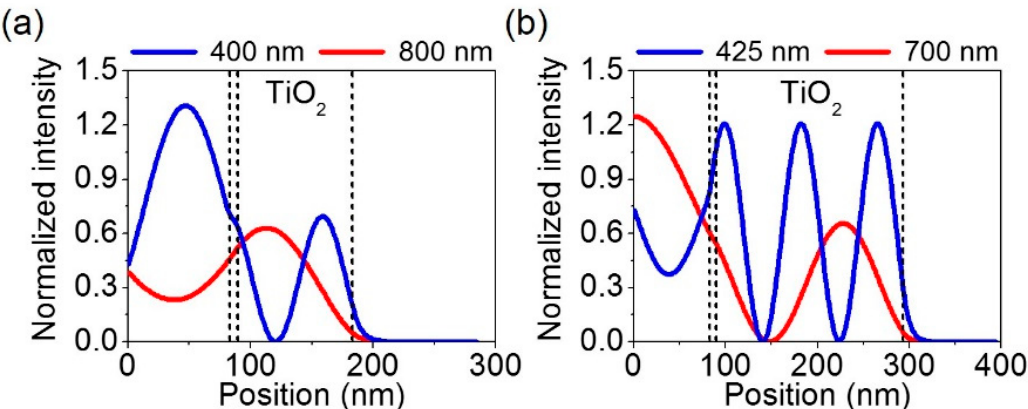
Figure 5. Normalized intensity distributions of electric field into the proposed structures where the thickness of TiO 2 layer is ( a ) 100 nm and ( b ) 210 nm with fixed thicknesses of SiO 2 , Cr and Al at 80, 5 and 100 nm.